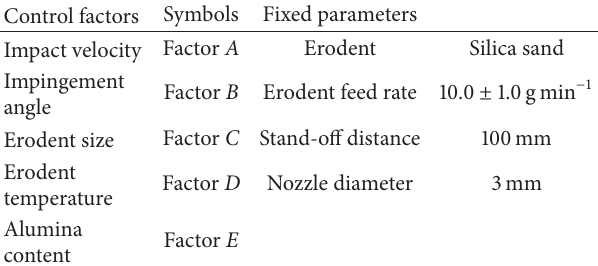
Table 1: Setting of parameters.